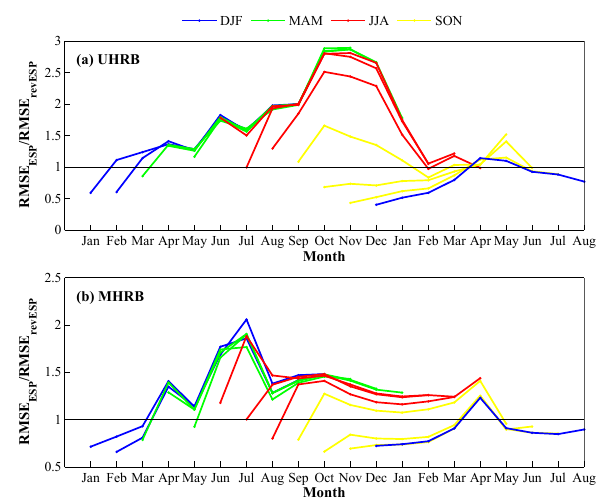
Figure 8. The RMSE ratio (RMSE ESP / RMSE revESP ) as a func- tion of start month and lead time over the upstream and midstream. The RMSE ESP (RMSE revESP ) is calculated between the SSI1 series from the offline simulation and that from the ESP (revESP) experi- ments with the human activities module switched